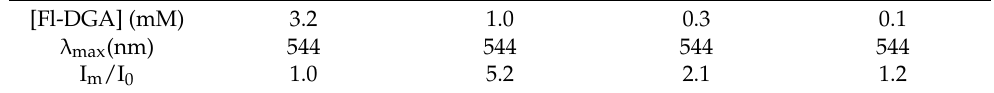
Table 4. Photophysical characteristics of Fl-DGA ( 1